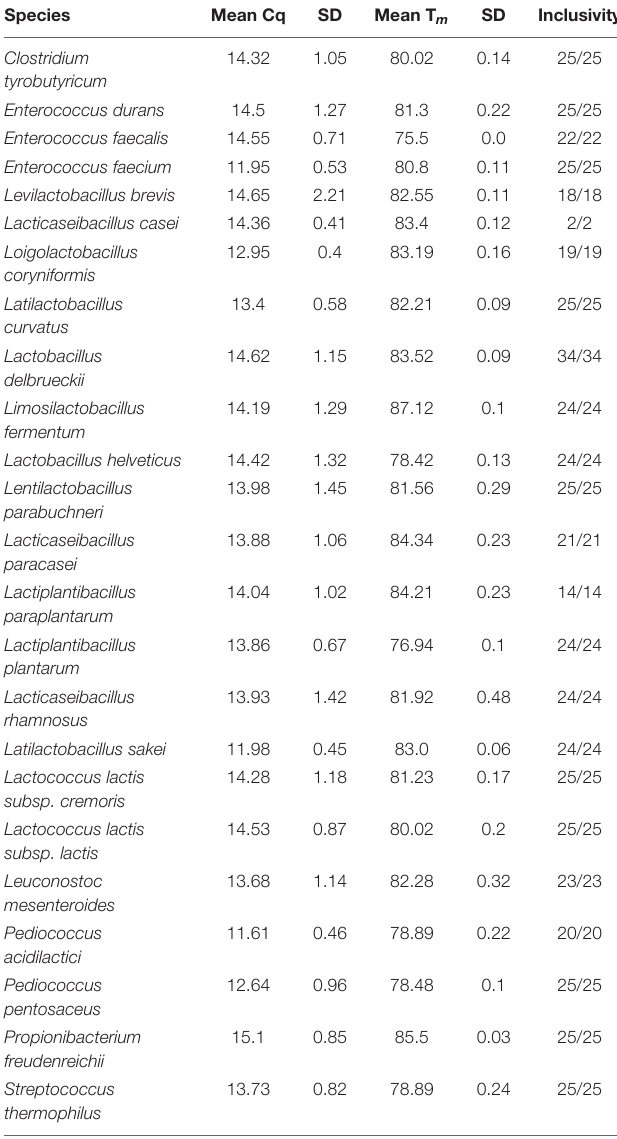
TABLE 2 | Standard qPCR results of inclusivity assessment.